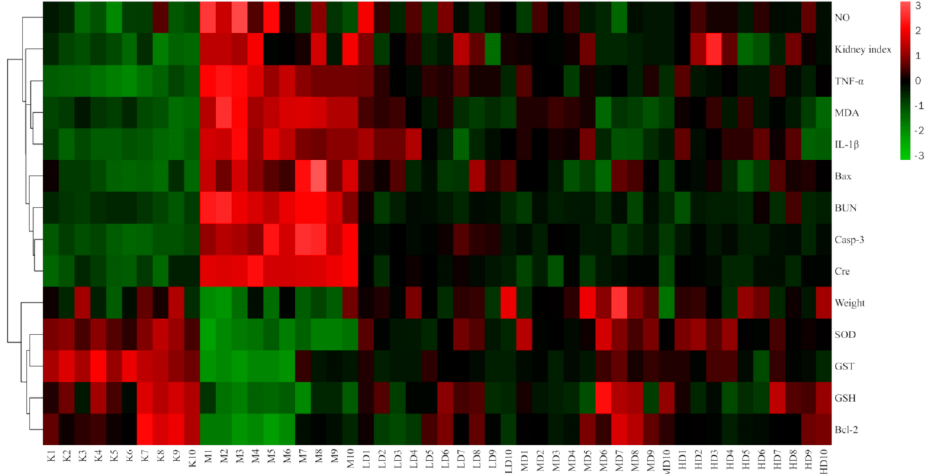
Figure 8. Clustering heatmap results. “ n ” indicates the number of mice, Kn the control group, Mn the model group, LD the low-dose group, MD the medium-dose group, and HD the high-dose group. Nitric oxide (NO); Tumor necrosis factor- α (TNF- α ); Malondialdehyde (MDA); Interleukin-1 β (IL-1 β ); Serum creatinine (Cre); Blood urea nitrogen (BUN); Caspase-3 (Casp-3); Superoxide dismutase (SOD); Glutathione S-transferase (GST); Glutathione (GSH).